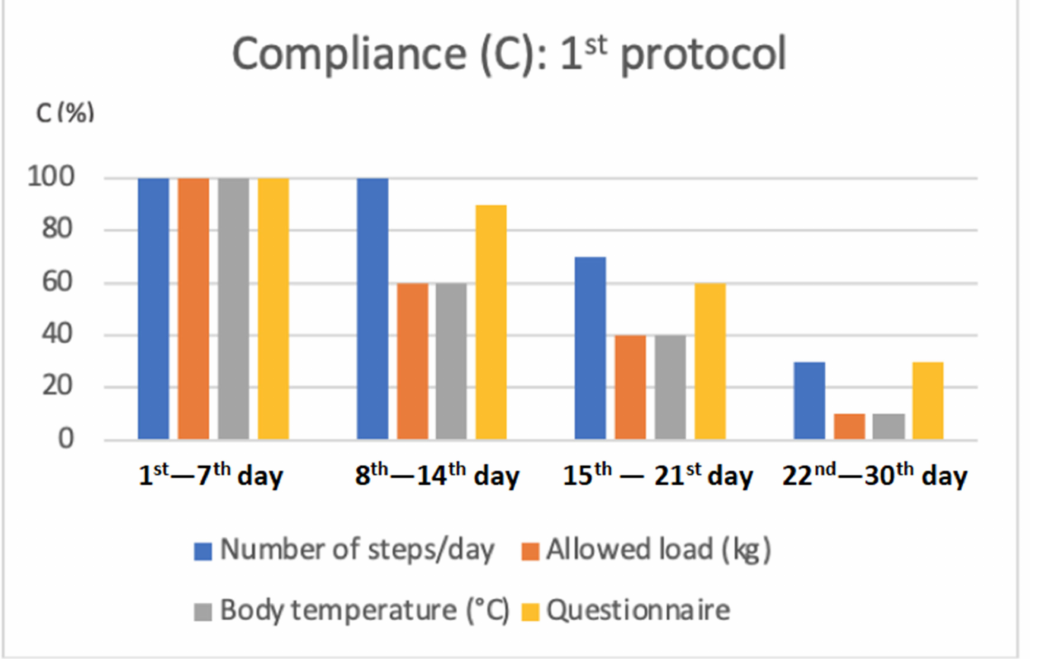
Figure 4. Graphical representation of the average compliance of patients, expressed as a percentage, in the insertion of the various parameters required within the first